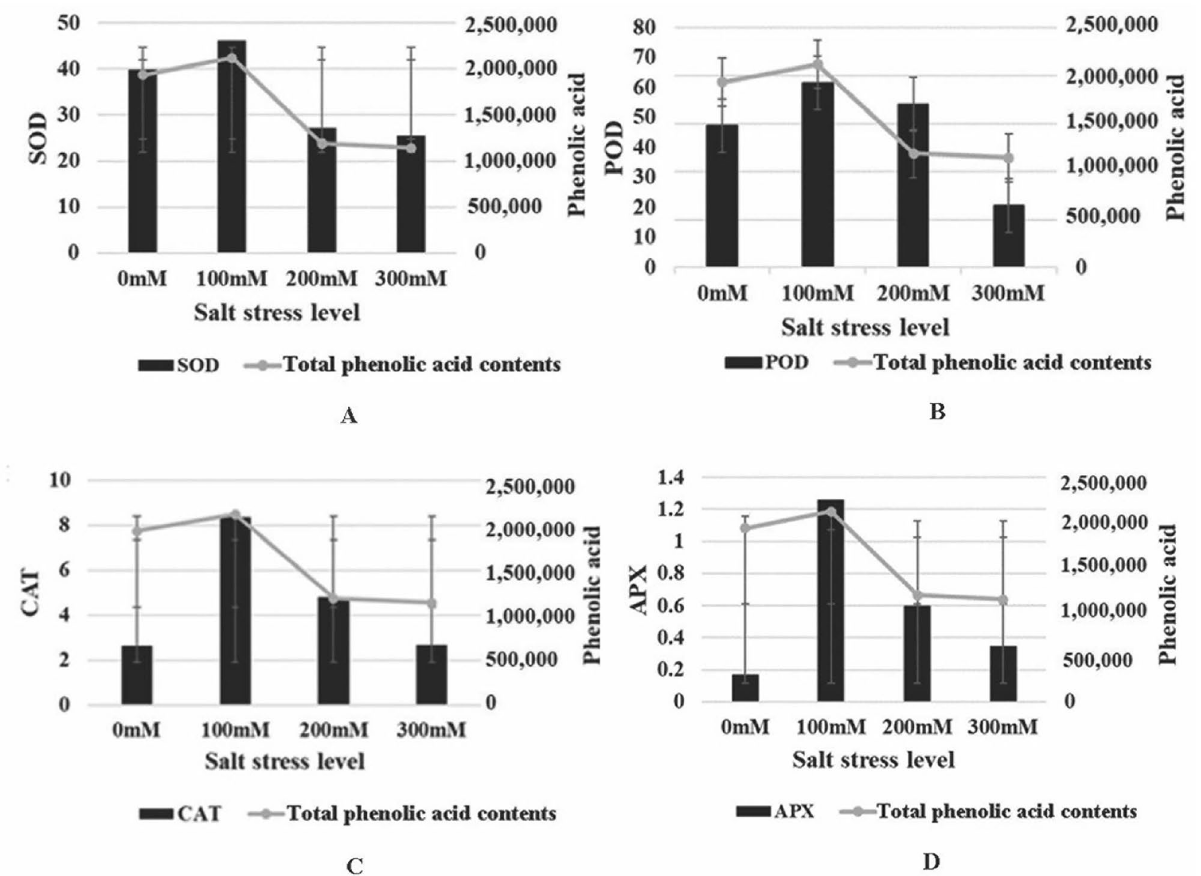
Figure 7. The correlation between antioxidant enzyme activity (superoxide dismutase (SOD, A ), peroxidase (POD, B ), catalase (CAT, C ), ascorbate peroxidase (APX, D )) and total phenolic acid content under salt